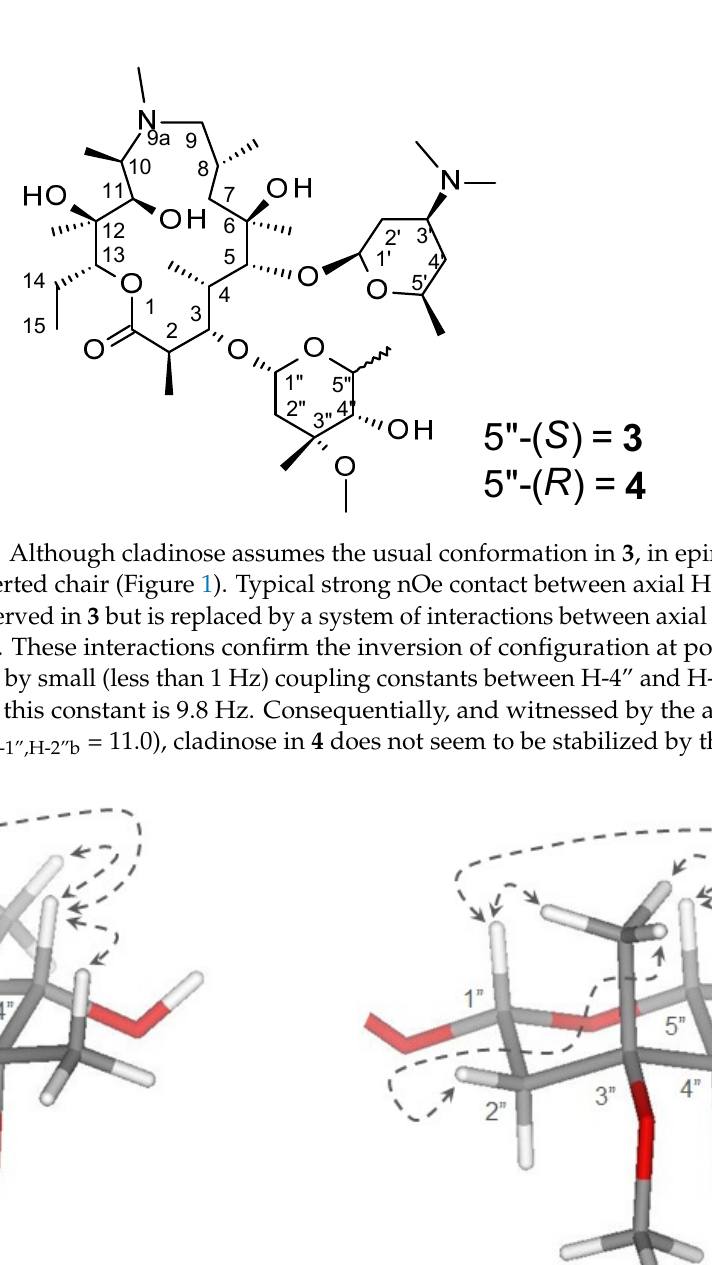
energy minimized, for illustrative purposes only). This “new” conformation of cladinose in 4 affects the mutual arrangement of the